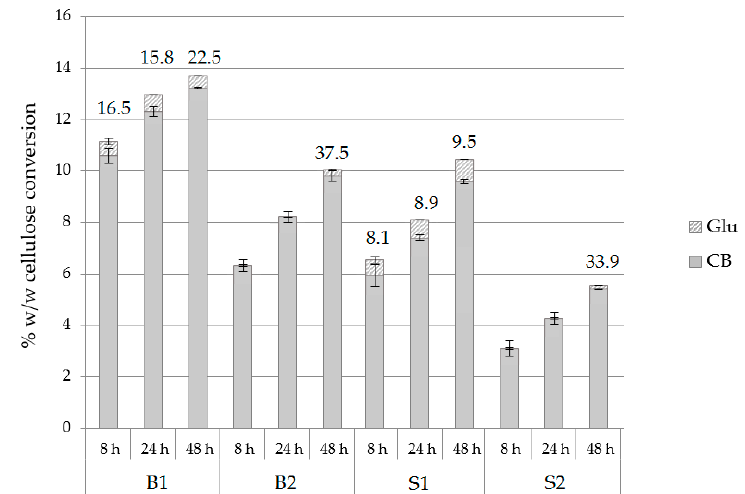
Figure 6. Hydrolysis yields from birch and spruce substrates, described as % w/w cellulose conversion into cellobiose and glucose of at pH 7.0, upon the addition of 1.98 mM conduritol-B-epoxide, at an enzyme loading of 25 mg/g of substrate, with buffer exchange at 8 and 24 h. CB:Glu and total mg CB per gram of substrate are also described.